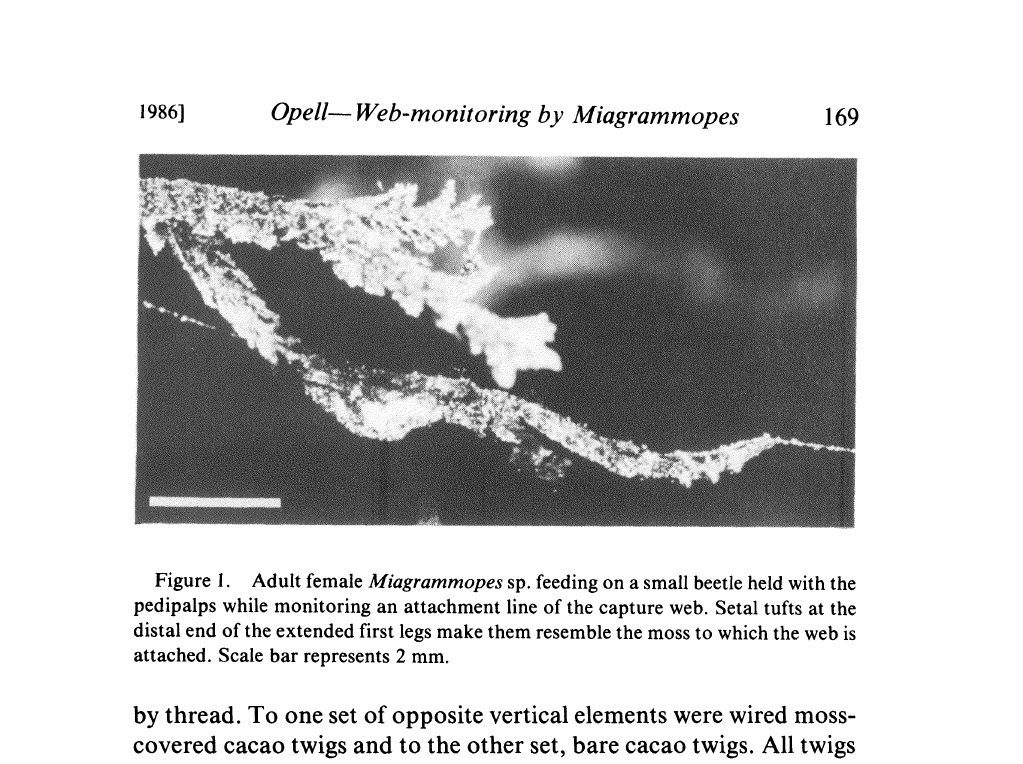
Figure I. Adult female Miagrammopes sp. feeding on a small beetle held with the pedipalps while monitoring an attachment line of the capture web. Setal tufts at the distal end of the extended first legs make them resemble the moss to which the web is attached. Scale bar represents 2